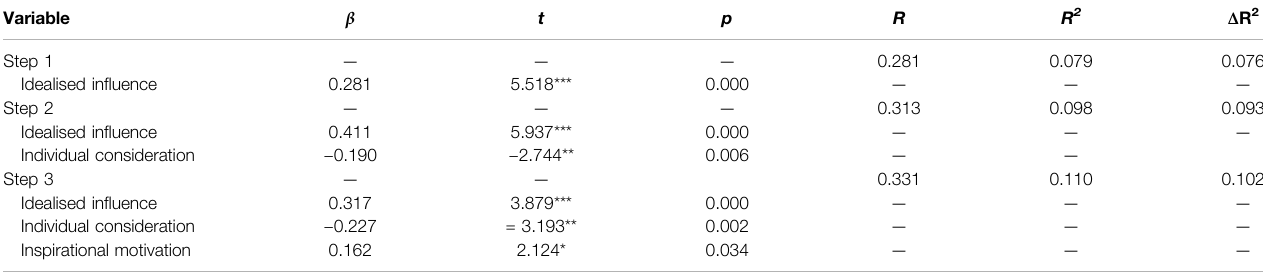
TABLE 3 | Summary of hierarchical regression analysis for variables predicting autonomous motivation for teaching. Variable